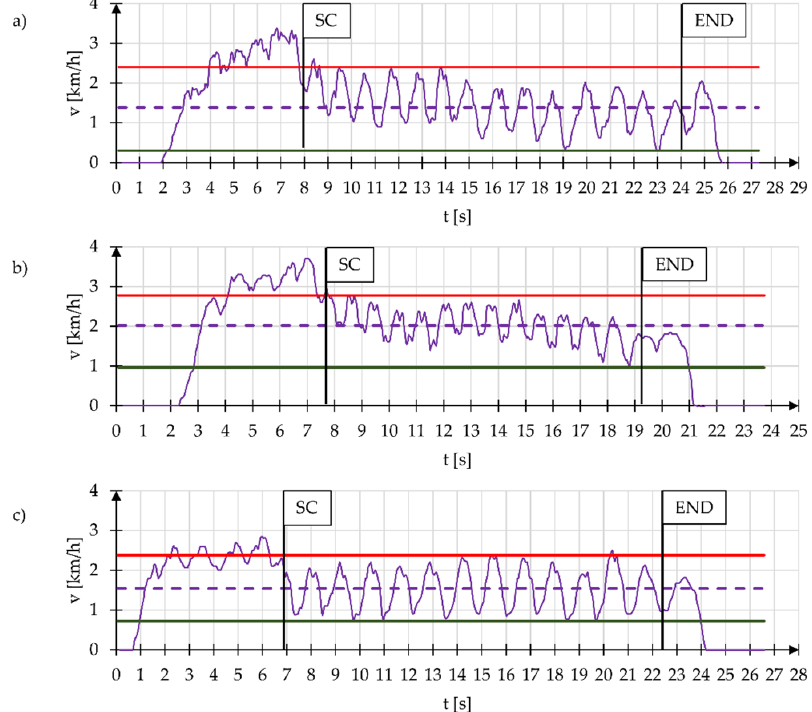
Figure 5. Speed waveforms for a wheelchair moving without electric motor assistance for subject 1 ( a ), subject 2 ( b ) and subject 3 ( c ), where SC – the starting points for the slope climb, END – the end points for the slope climb.